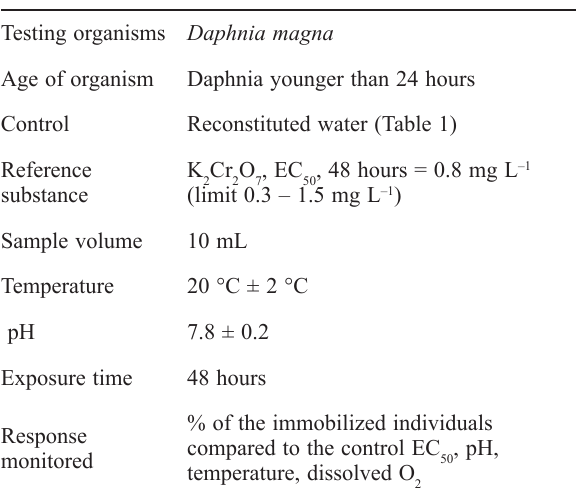
Table 3 – Conditions of acute toxicity test on daphnia Testing organisms Daphnia magna